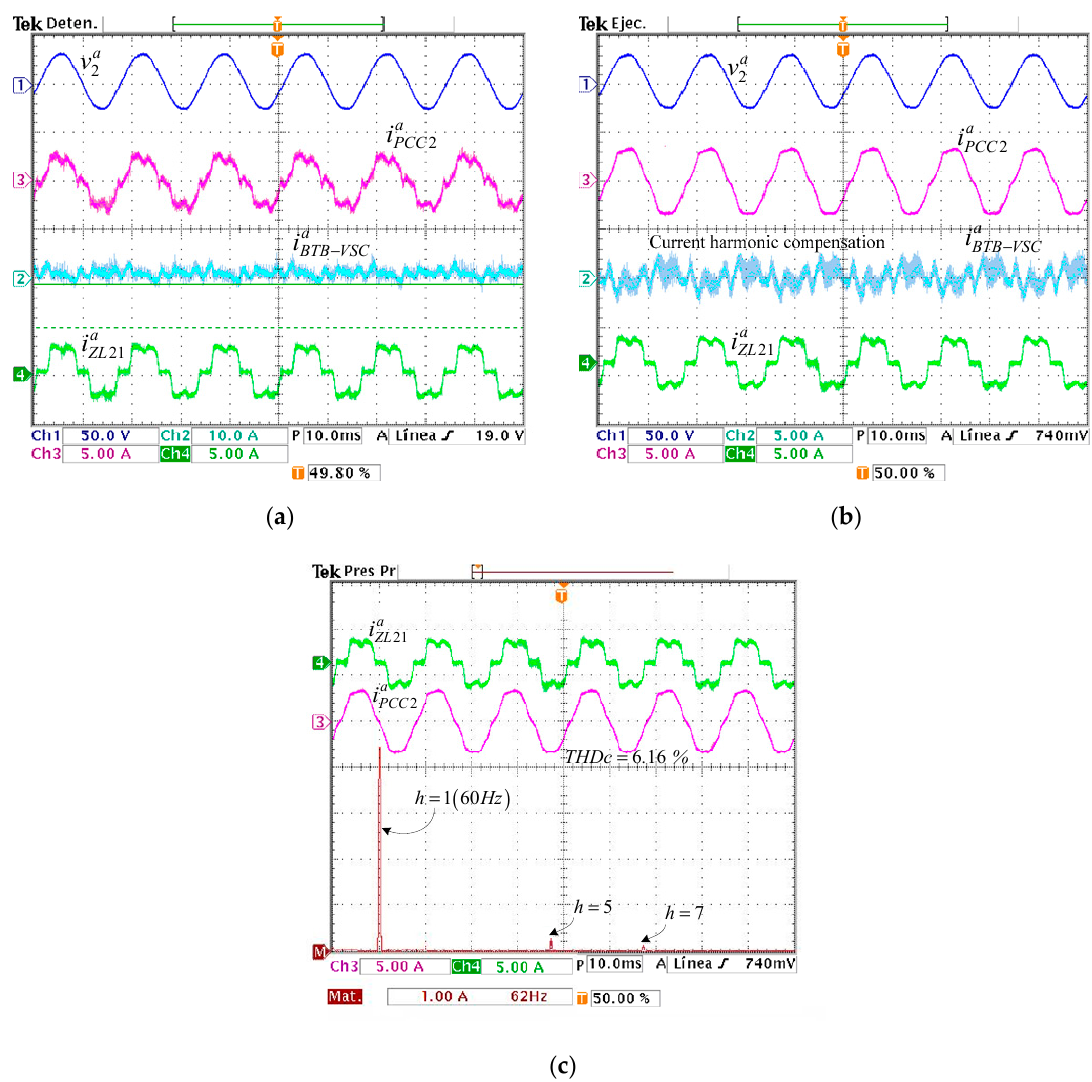
Figure 15. Test results for current harmonic compensation: ( a ) Before compensation. Ch1, voltage measured at the PCC2; Ch2, current injected with the BTB-VSC at the PCC2; Ch3, current measured at the PCC2; Ch4, current for the load Z L 21 . Vertical sensitivities: Ch1, 50 V/div; Ch2, 10 A/div, Ch3 and Ch4, 5 A/div. Horizontal sensitivity: 10 ms/div. ( b ) After compensation. Ch1, voltage measured at the PCC2; Ch2, current injected with the BTB-VSC at the PCC2; Ch3, current measured at the PCC2; Ch4, current for the load Z L 21 . Vertical sensitivities: Ch1, 50 V/div; Ch2-Ch4, 5 A/div. Horizontal sensitivity, 10 ms/div. ( c ) Current for the nonlinear load and the associated frequency spectrum. Ch3, current measured at the PCC2; Ch4, current for the load Z L 21 . Mat., frequency spectrum. Vertical sensitivities: Ch3 and Ch4, 5 A/div. Mat., 1 A/div. Horizontal sensitivity: Ch3 and Ch4, 10 ms/div; Mat., 62 Hz/div.